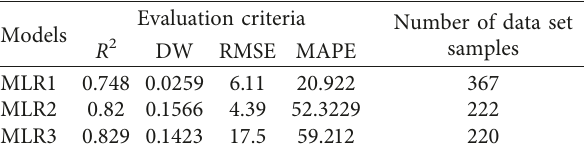
Table 4: Results obtained for MLR